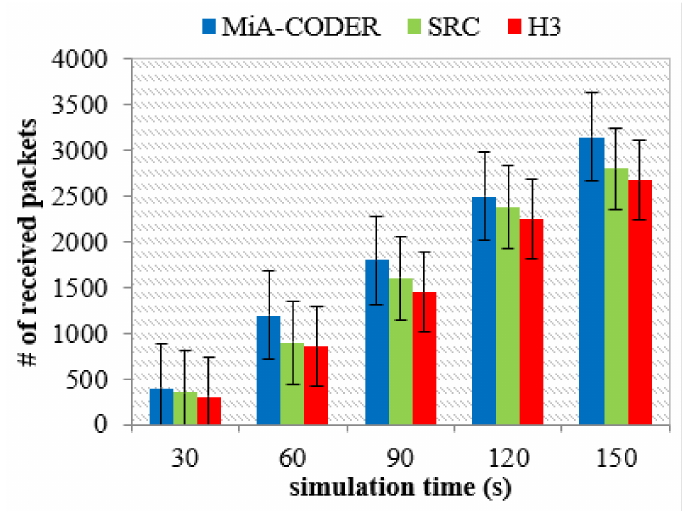
Figure 11. Number of received packets (before coverage hole repair) vs. simulation